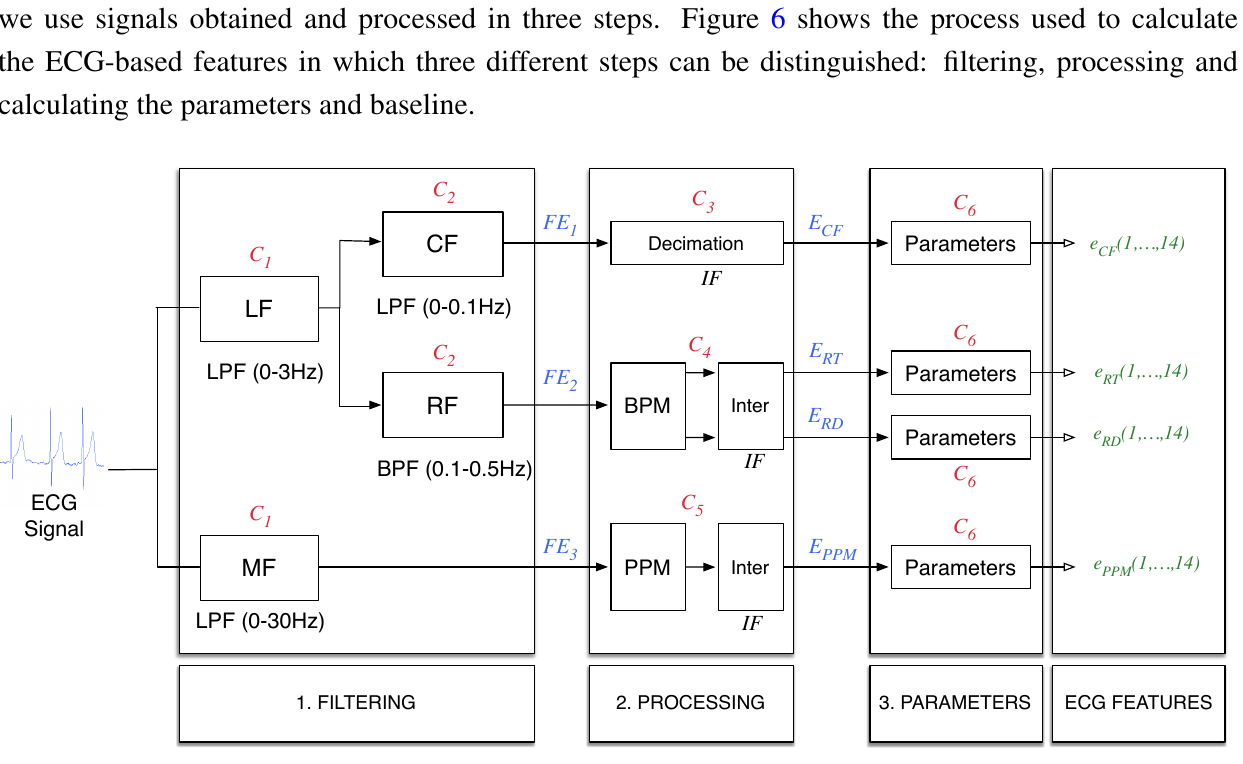
Figure 6. ECG-based feature extraction